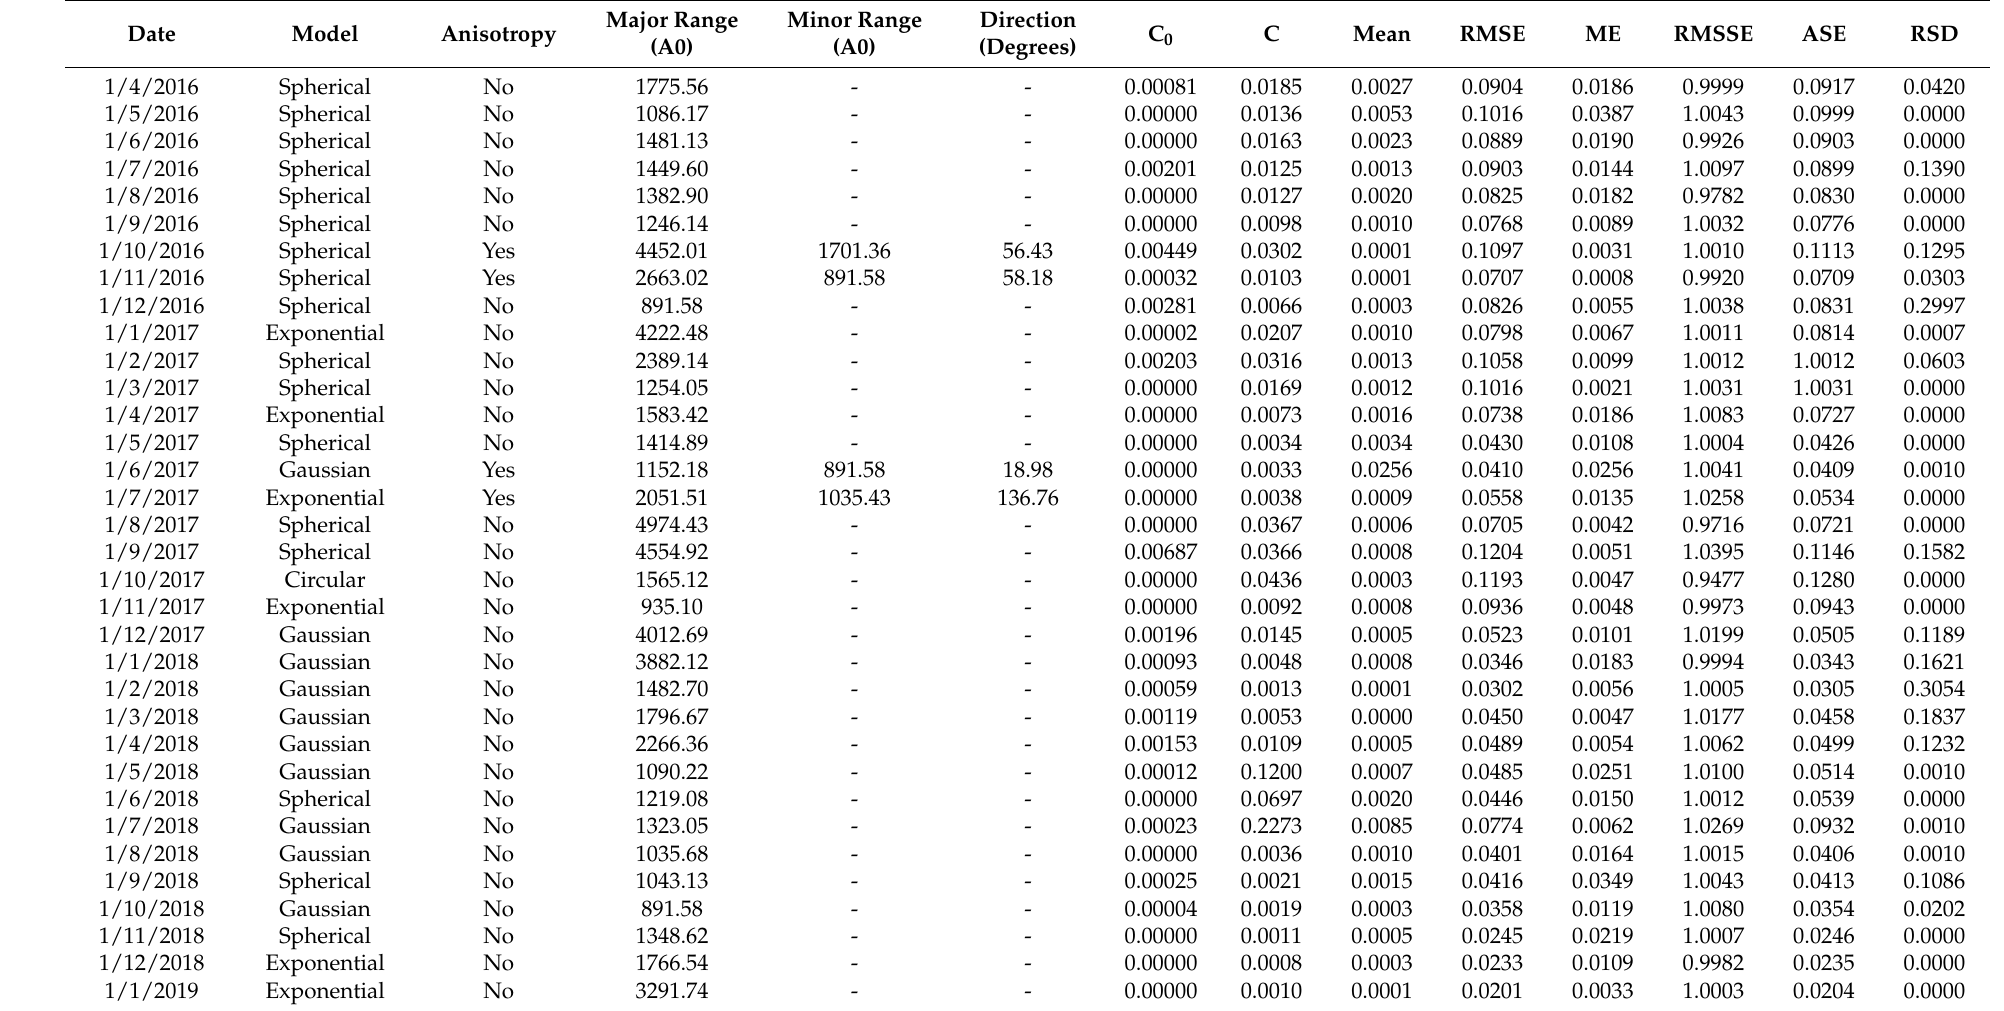
Table 2. Characteristics of selected models for the spatial distribution of Leucoptera coffeella